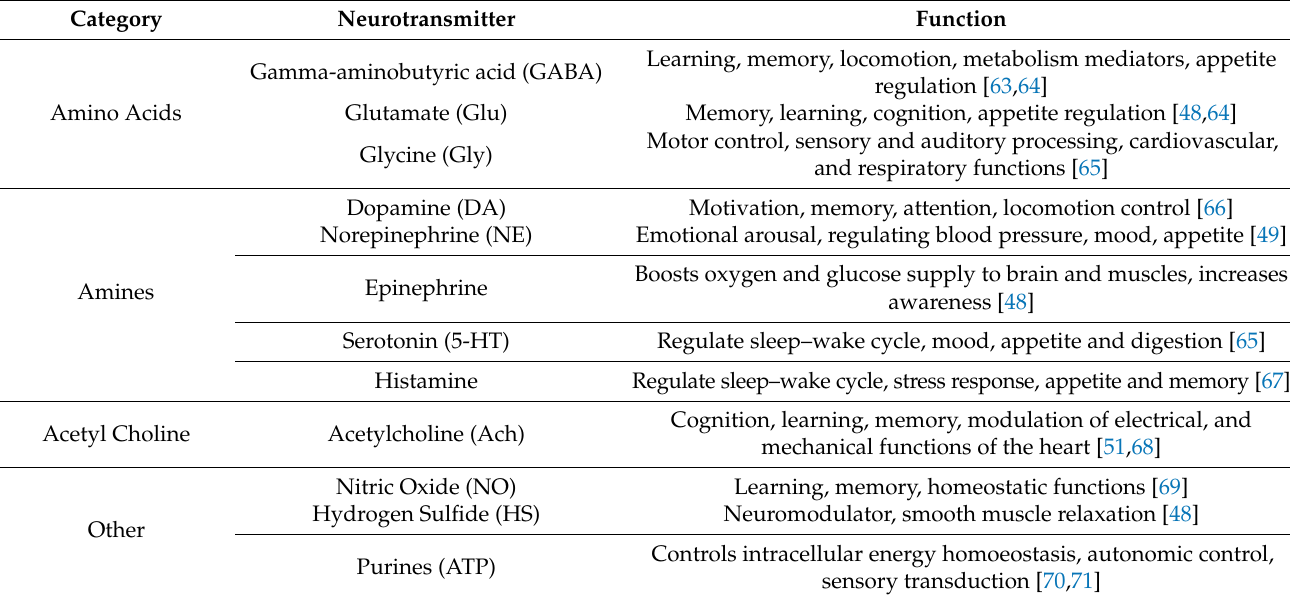
Table 1. Neurotransmitter classification by chemical